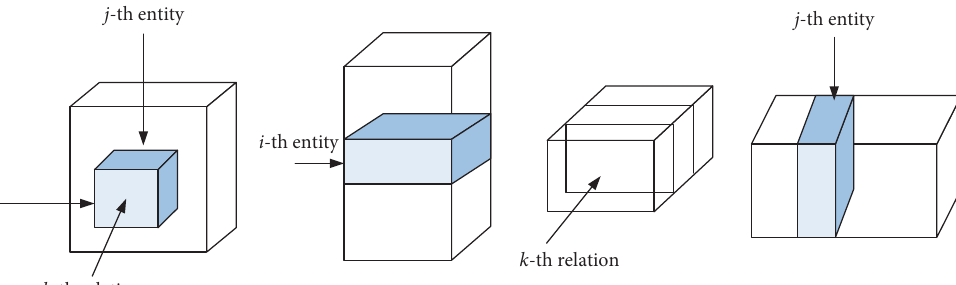
Figure 1: The decomposition diagram of tensor